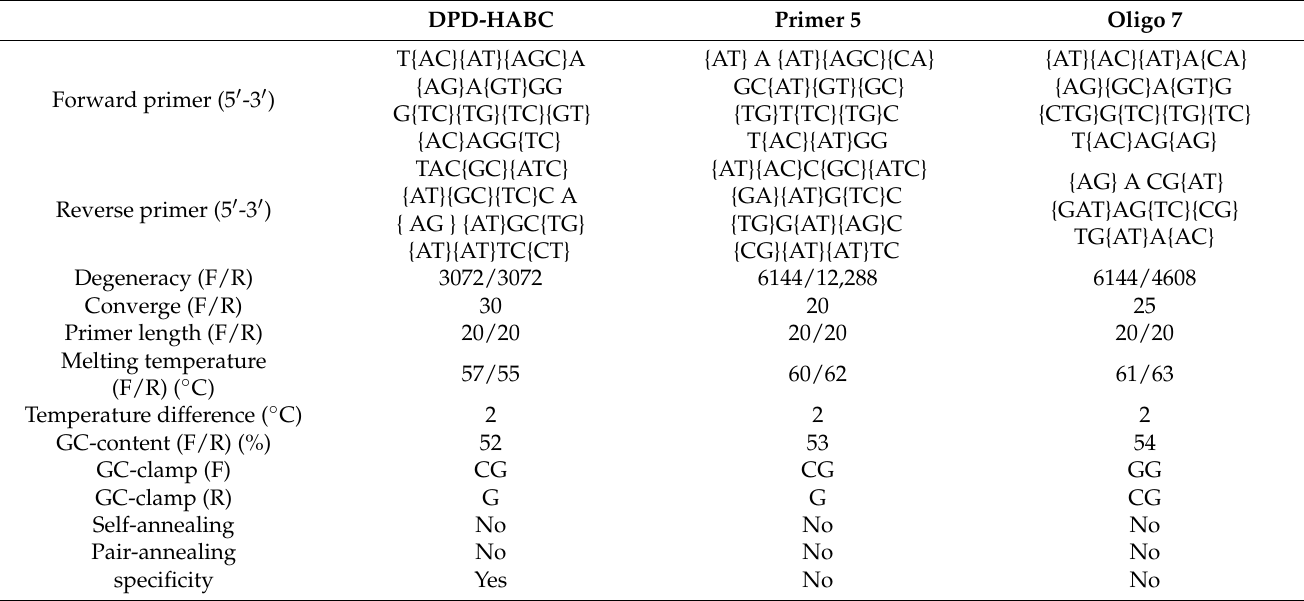
Table 2. Comparison of three methods on 500 bps DNA template.